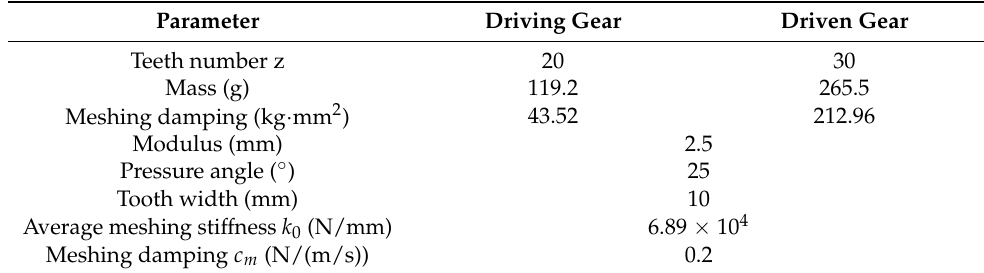
Table 1. Parameters of the gear system.